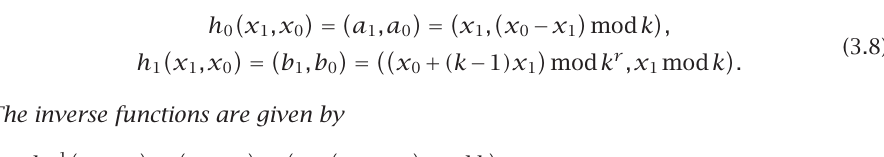
f f 0 and 1 of Theorem